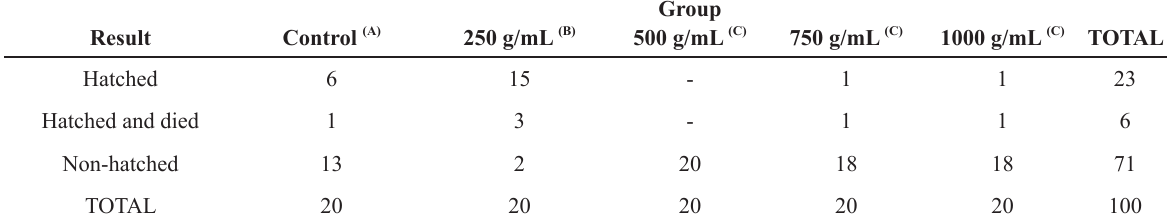
Evaluation of embryotoxic and embryostatic effects of synthetic tannic acid in A. aegypti eggs over 14 days